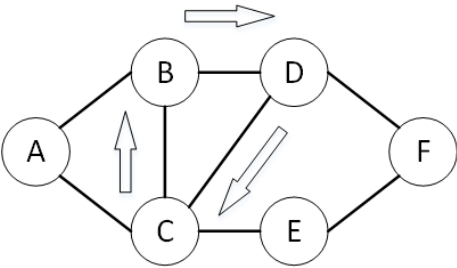
Figure 5. An Example of Routing Loop.